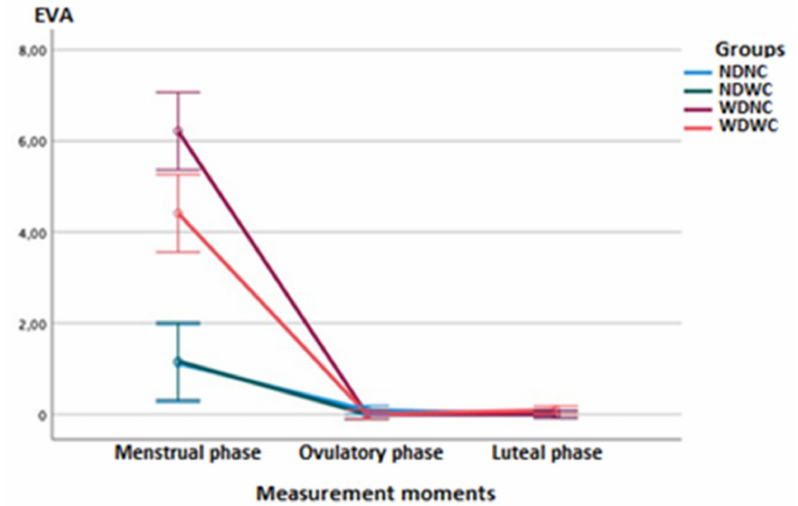
Figure 2. Linear graphs of the means completed with the error bars at 99% of the Cl, for the pain intensity variable (VAS scale) that show the differences between the groups (NDNC, NDWC, WDNC, WDWC) and the measurement moments (menstrual phase, ovulatory phase, and luteal phase). Regarding intra-group comparisons, the ANOVA test showed statistically